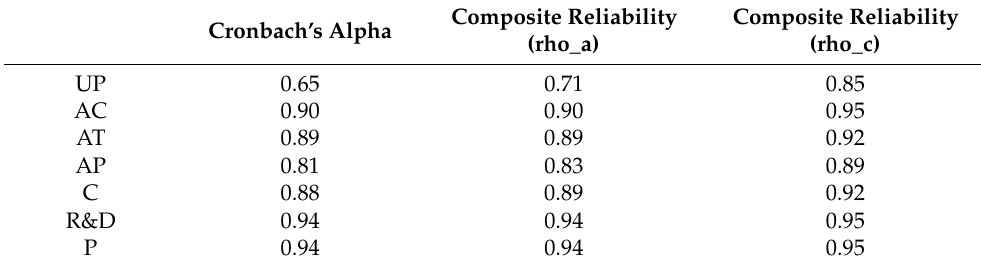
Table 1. Internal consistency reliability.